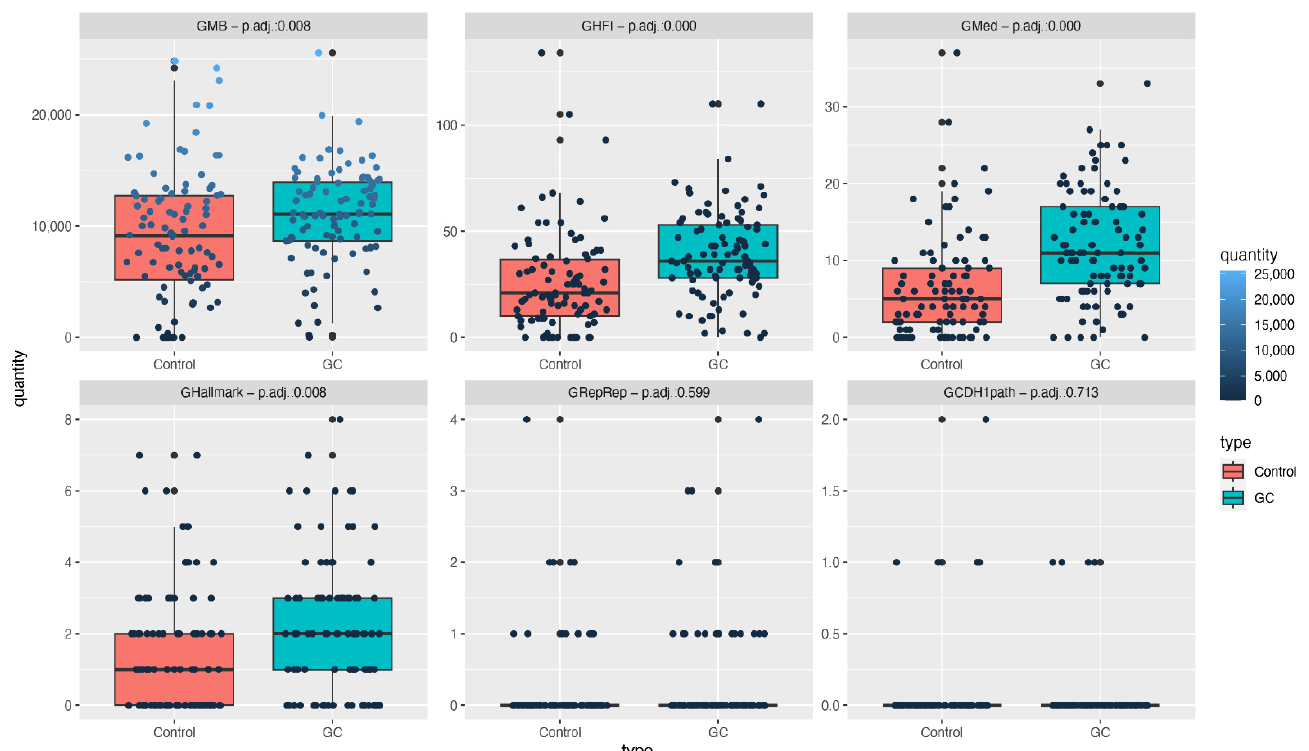
Figure 3. Quantity of mutations in gastric cancer (blue) and non-cancer (red) groups. There were more mutations in the GC group, reaching statistical significance for the total number of mutations (GMB) in the GHI, GMed and GHallmark gene subsets. No statistical differences occurred in the GRepRep or GCDH1path subsets.